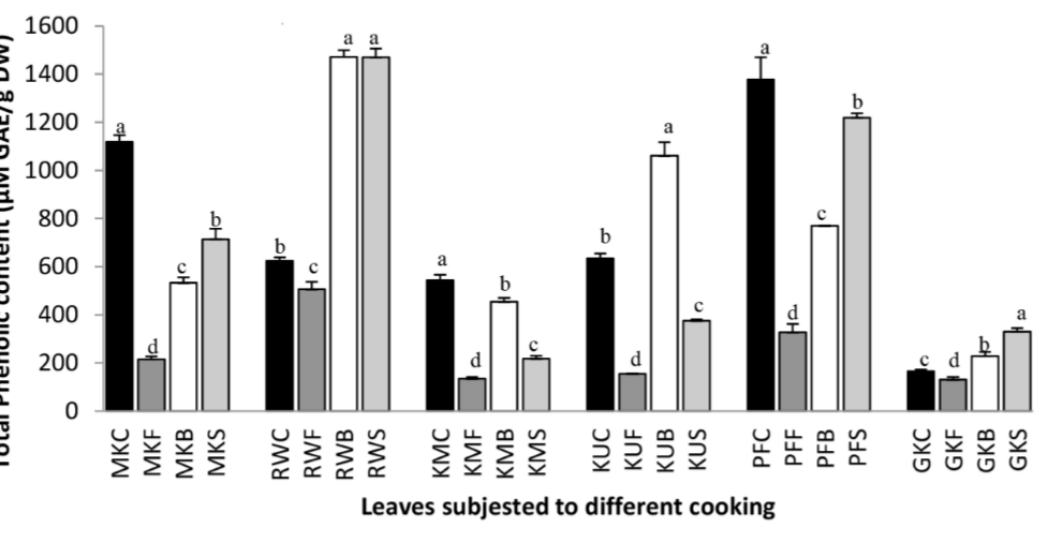
Figure 1. The total phenolic content of raw and cooked extracts of some green leafy vegetables. Values represent the means of triplicate readings. MK, O. zeylanica ; RW, C. auriculata ; KM, S. grandiflora ; KU, G. lactiferum ; PF, P. edulis ; GK, C. asiatica . C—fresh leaves; F—fried; B—boiled; S—steamed. Data are means ± standard deviations of three replicate determinations. Columns with different letters for each vegetable are significantly different ( p < 0.05). GAE: gallic acid equivalence; DW: dry weight.